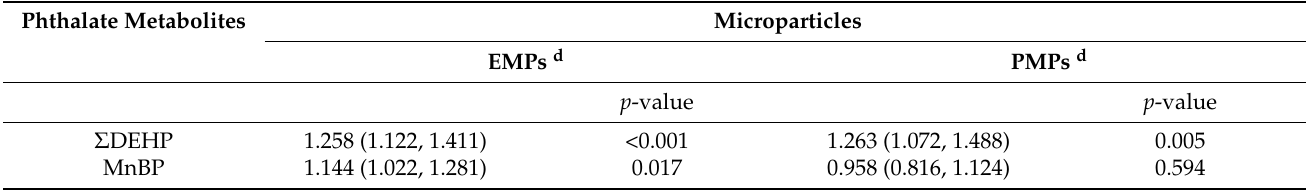
Table 4. Multiplicative factors (95% confidence intervals) for a change in serum endothelial and platelet microparticle level a associated with an interquartile range change in urinary phthalate metabolites level b in multiple linear regression model c